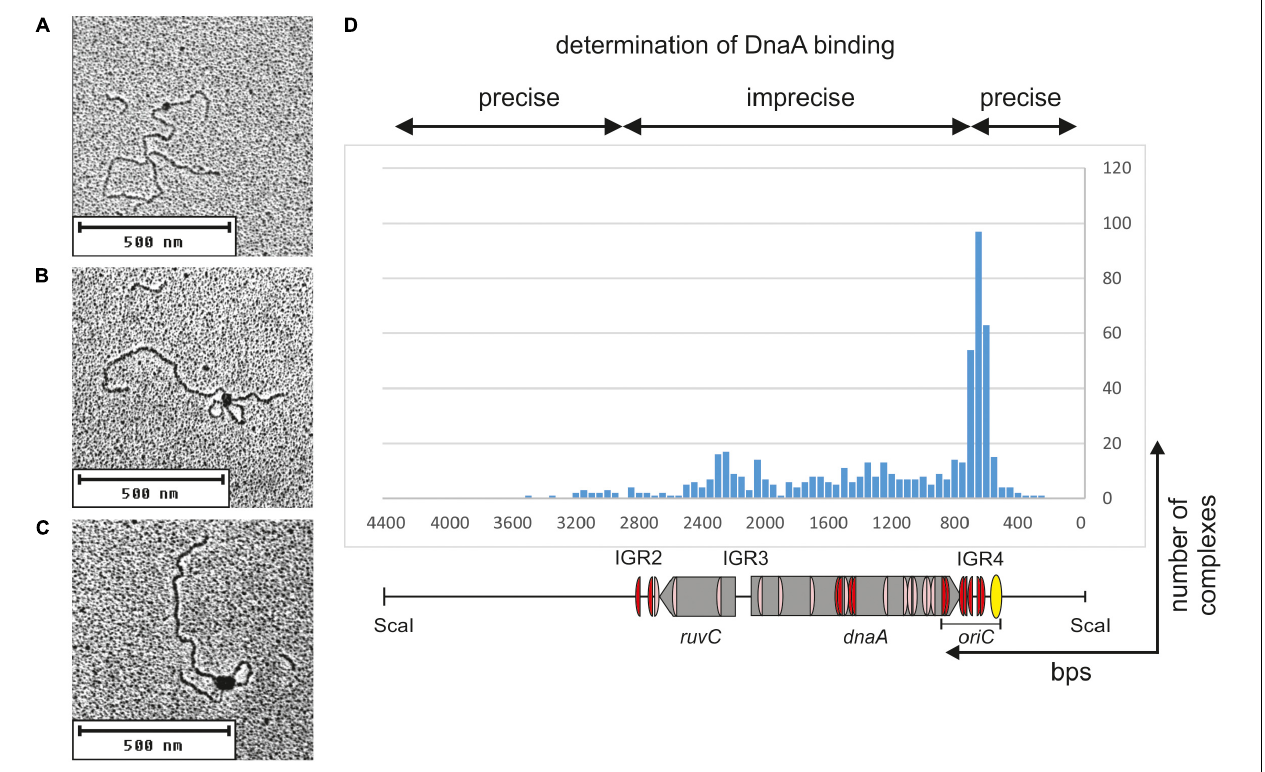
FIGURE 5 | Electron microscopy analysis of the StrepCjDnaA interaction with pOC_24 plasmid. The plasmid was incubated with StrepCjDnaA protein, fixed with glutaraldehyde and digested with ScaI. Representative pictures present the following: (A) StrepCjDnaA binding to the IGR4 region. (B) The simultaneous interaction of StrepCjDnaA with IGR4 and DnaA boxes in the dnaA gene. (C) Large StrepCjDnaA complex interactions with multiple sites along IGR4- dnaA. (D) Histogram of complexes of supercoiled pOC_24 with StrepCjDnaA. The most characteristic features of the plasmid are shown below the histogram. The distribution of the complexes was calculated based on an analysis of 300